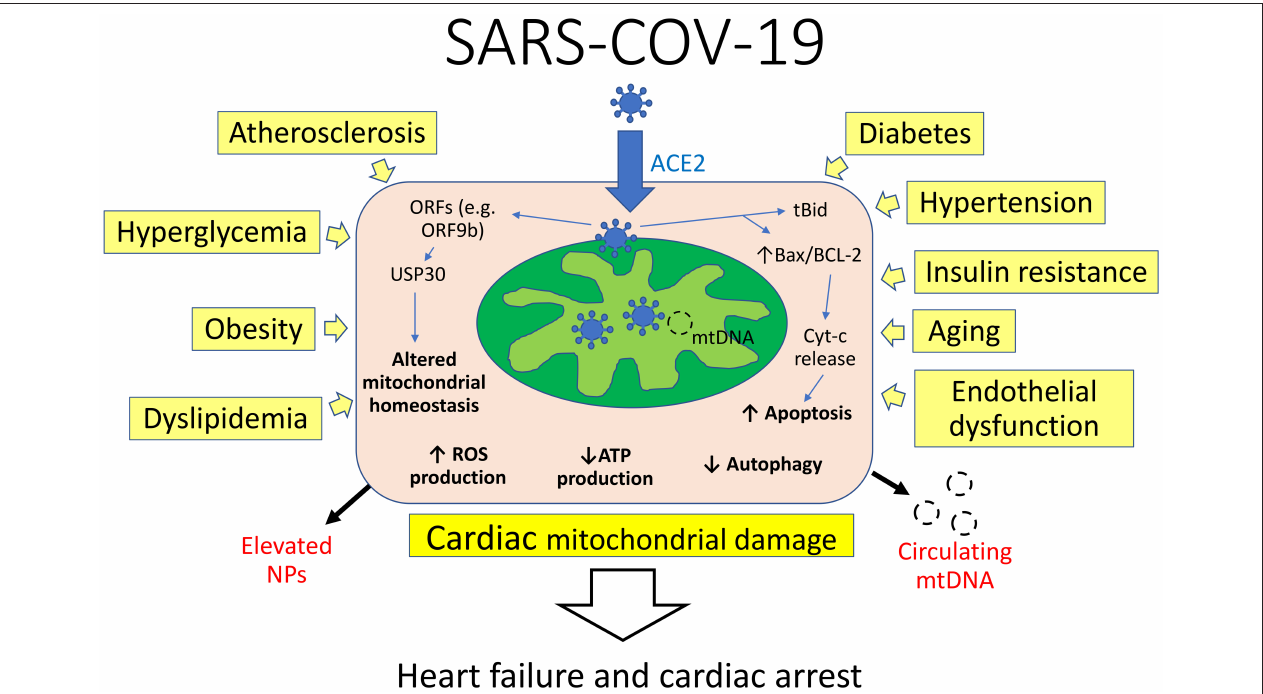
FIGURE 1 | Interplay of mechanisms of cardiac mitochondrial damage in COVID-19. Viral RNA and protein localize to mitochondria and manipulate their function by angiotensin-converting enzyme 2 (ACE2) regulation and open-reading frames (ORFs) to evade host cell immunity and facilitate virus replication. ORFs can target the mitochondrial deubiquitinase USP30, altering mitochondrial homeostasis and function. The virus promotes activation of truncated Bid (tBid) and alters Bax/BCL-2 ratio, favoring the release of apoptogenic factors. Concomitantly, several cardiovascular risk factors can compromise mitochondrial integrity and function by decreasing ATP levels and increasing reactive oxygen species (ROS) production. This in turn leads to cardiac mitochondrial damage and heart failure, associated with elevation of natriuretic peptides (NPs) and circulating mitochondrial DNA